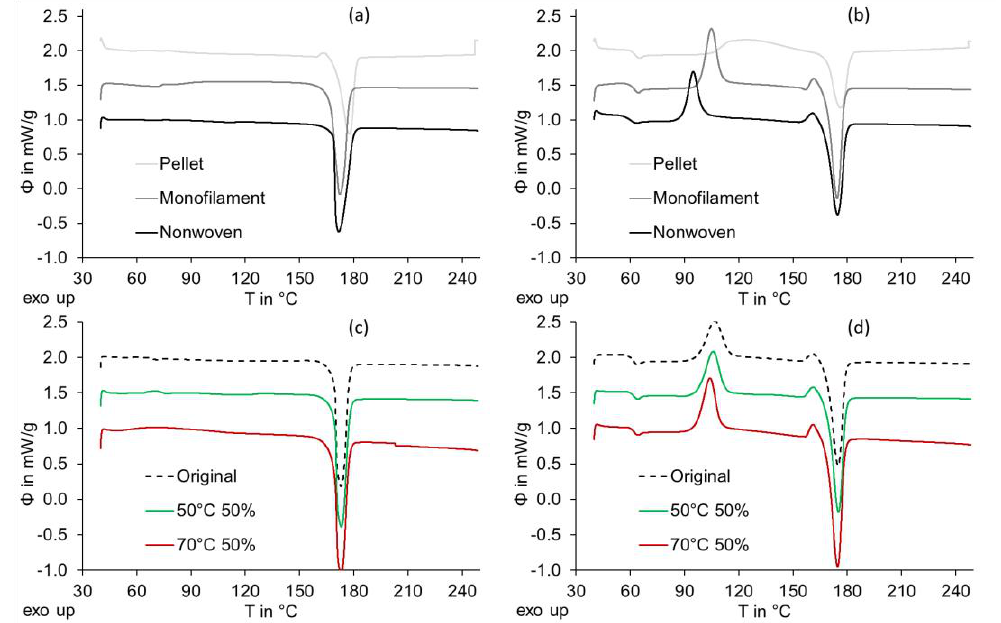
Figure 3. DSC thermograms, first ( a , c ) and second ( b , d ) runs, of PLA materials: ( a , b ) pellet, monofilament and nonwoven NW-I of the same grade PLA; ( c , d ) nonwoven NW-L before and after artificial aging under indicated conditions.